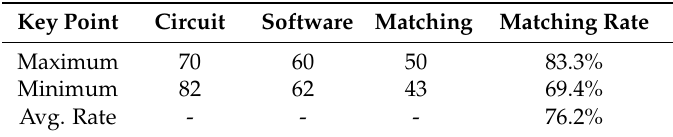
Figure 10. Matching of circuit and software output. The red plus signs are the local maximum points and green ones are the minimum points. The lines connect the matched points in the circuit and software output images. Table 3. Matching experiment